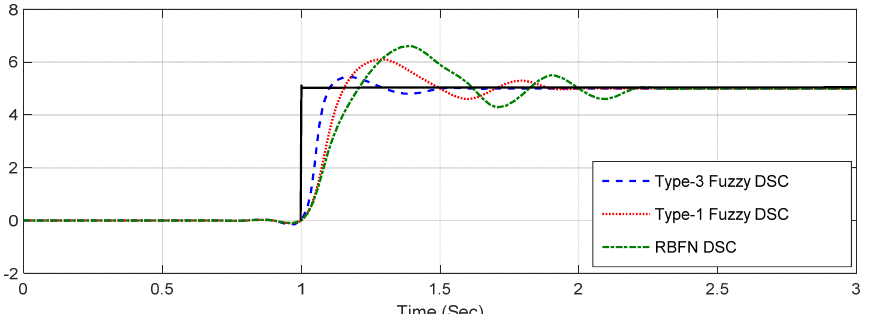
Figure 10. Comparison of dynamic surface control performance based on the type-3 fuzzy system, type-1 fuzzy system and RBFN.